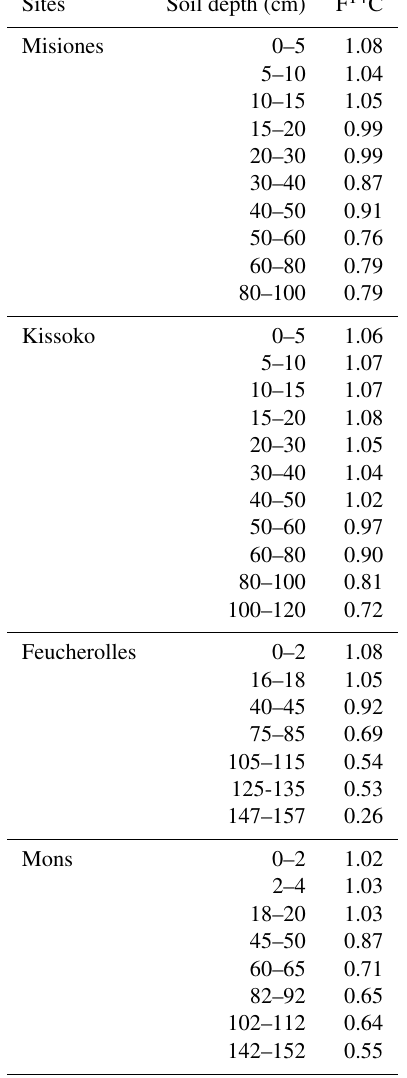
Table 5. F 14 C profile obtained for each site. Sites Soil depth (cm) F 14 C